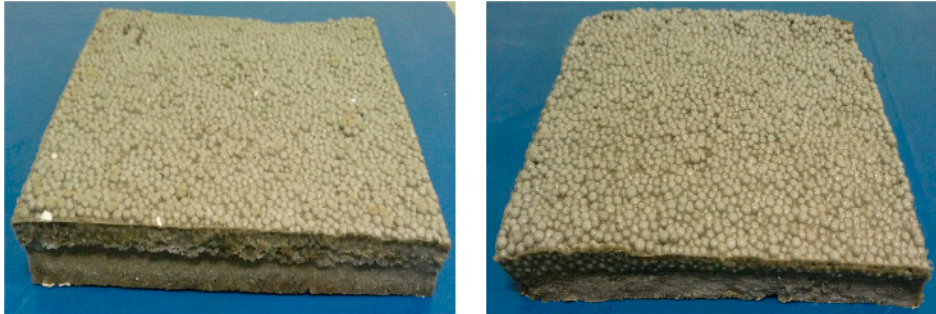
Figure 6. The proposed place-type resilient material. Table 9. Test results of the properties of the place-type resilient materials.